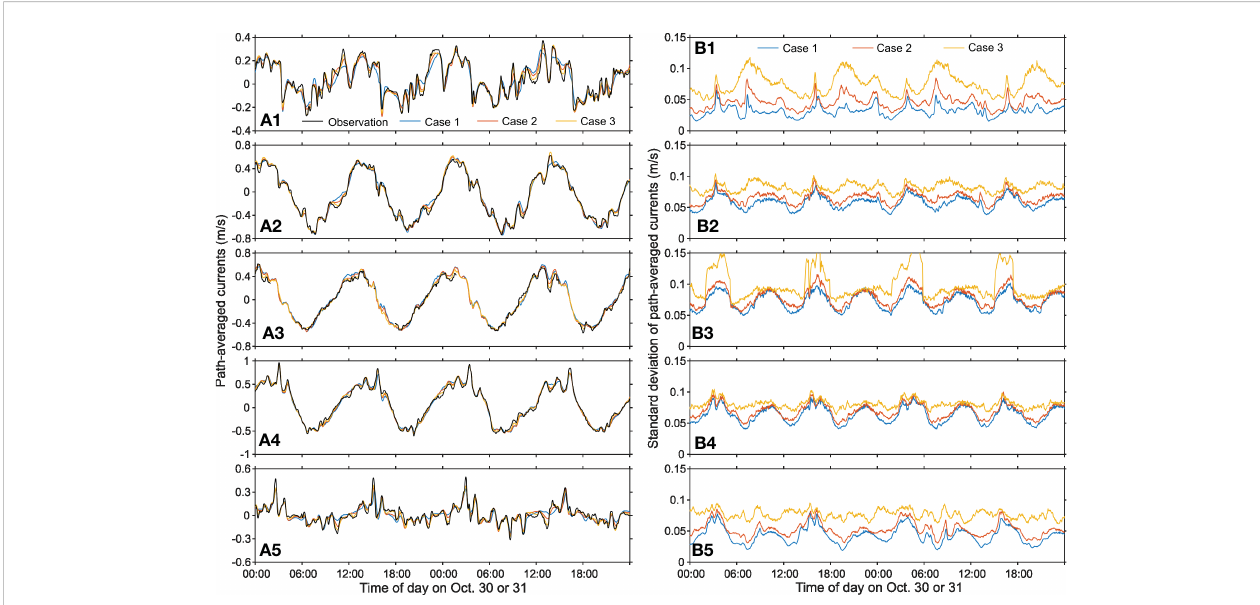
FIGURE 4 Results of data assimilation with 980 ensemble members. (A17 – A5) Path-averaged currents along the station pairs S1S2, S1S3, S2S3, S2S4, and S3S4; (B1 – B5) The standard deviation of path-averaged current ensembles (i.e., the forecast ensemble spread) just before the Kalman fi lter update in each transmission time for the same station pairs as of (A1 – A5) . The blue, red, and yellow lines are the results of cases 1, 2, and 3, respectively, and the black line in (A1 – A5) indicates the observed path-averaged current.